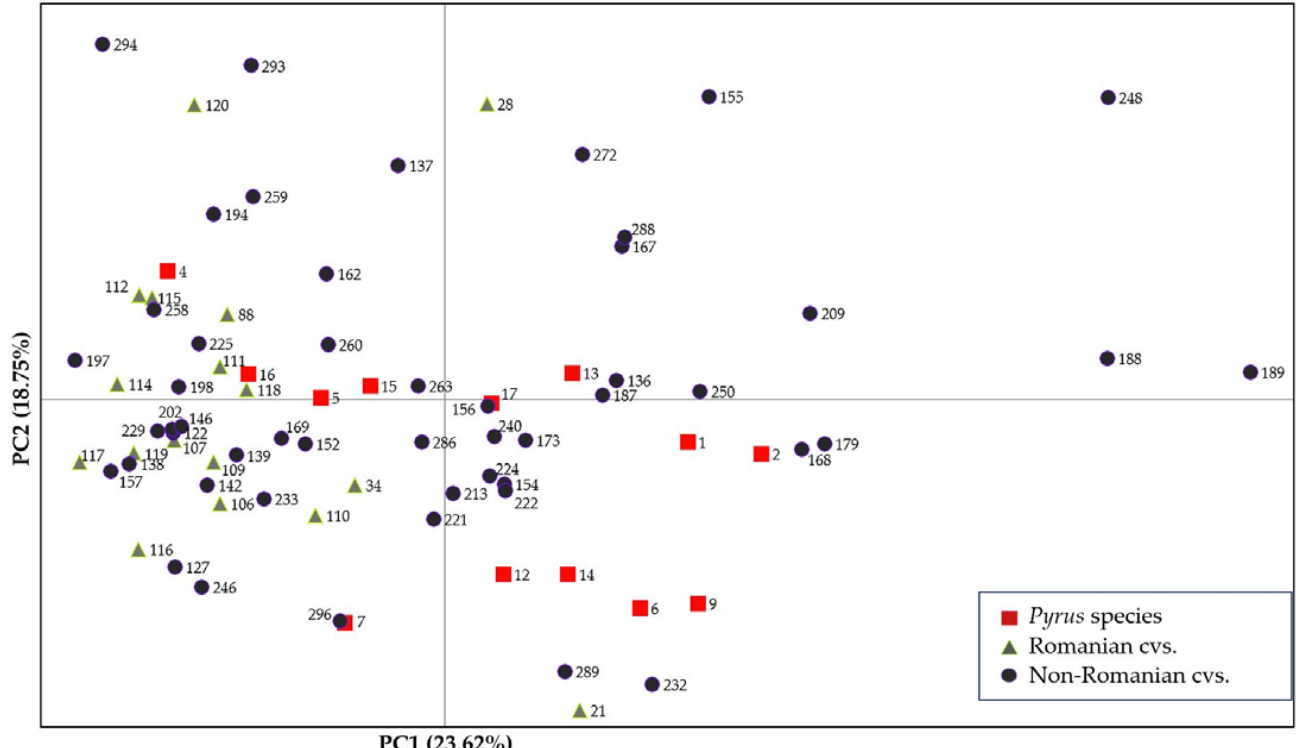
Figure 4. Relationships between the 80 genotypes of pear based on nine SSRs according to the principal coordinate analysis (PCoA). The first principal coordinate is responsible for 23.62% of the molecular variance, the second for 18.75%, and the third for 18.39%. The genotypes were divided into three groups (species, Romanian cultivars, and non-Romanian cultivars), each with its own color. Their codes (numbers) correspond to the names of the genotypes in Table 1 ( Pyrus species), Table 2 (Romanian cultivars), and Table 3 (non-Romanian cultivars).